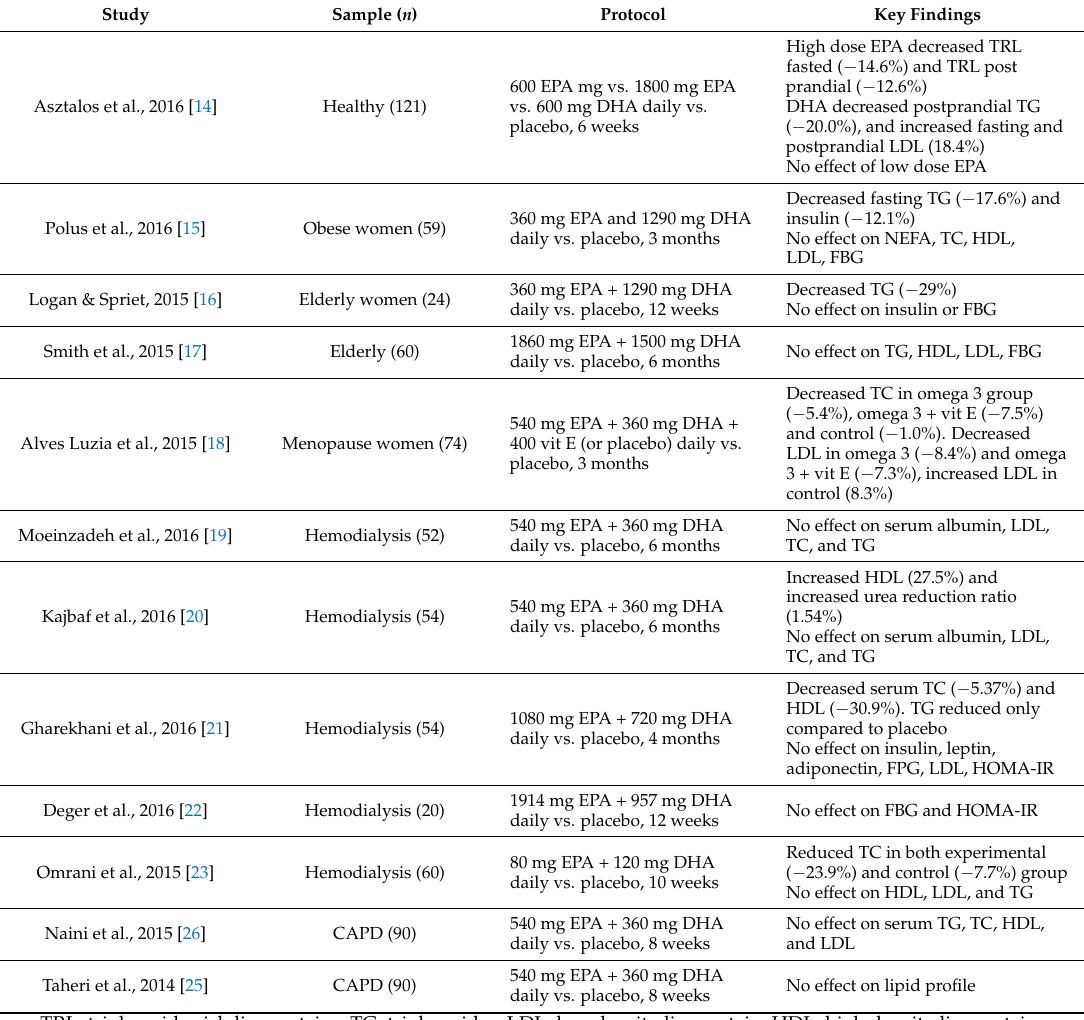
Table 1. Metabolic and lipid profile in healthy, ageing and chronic renal